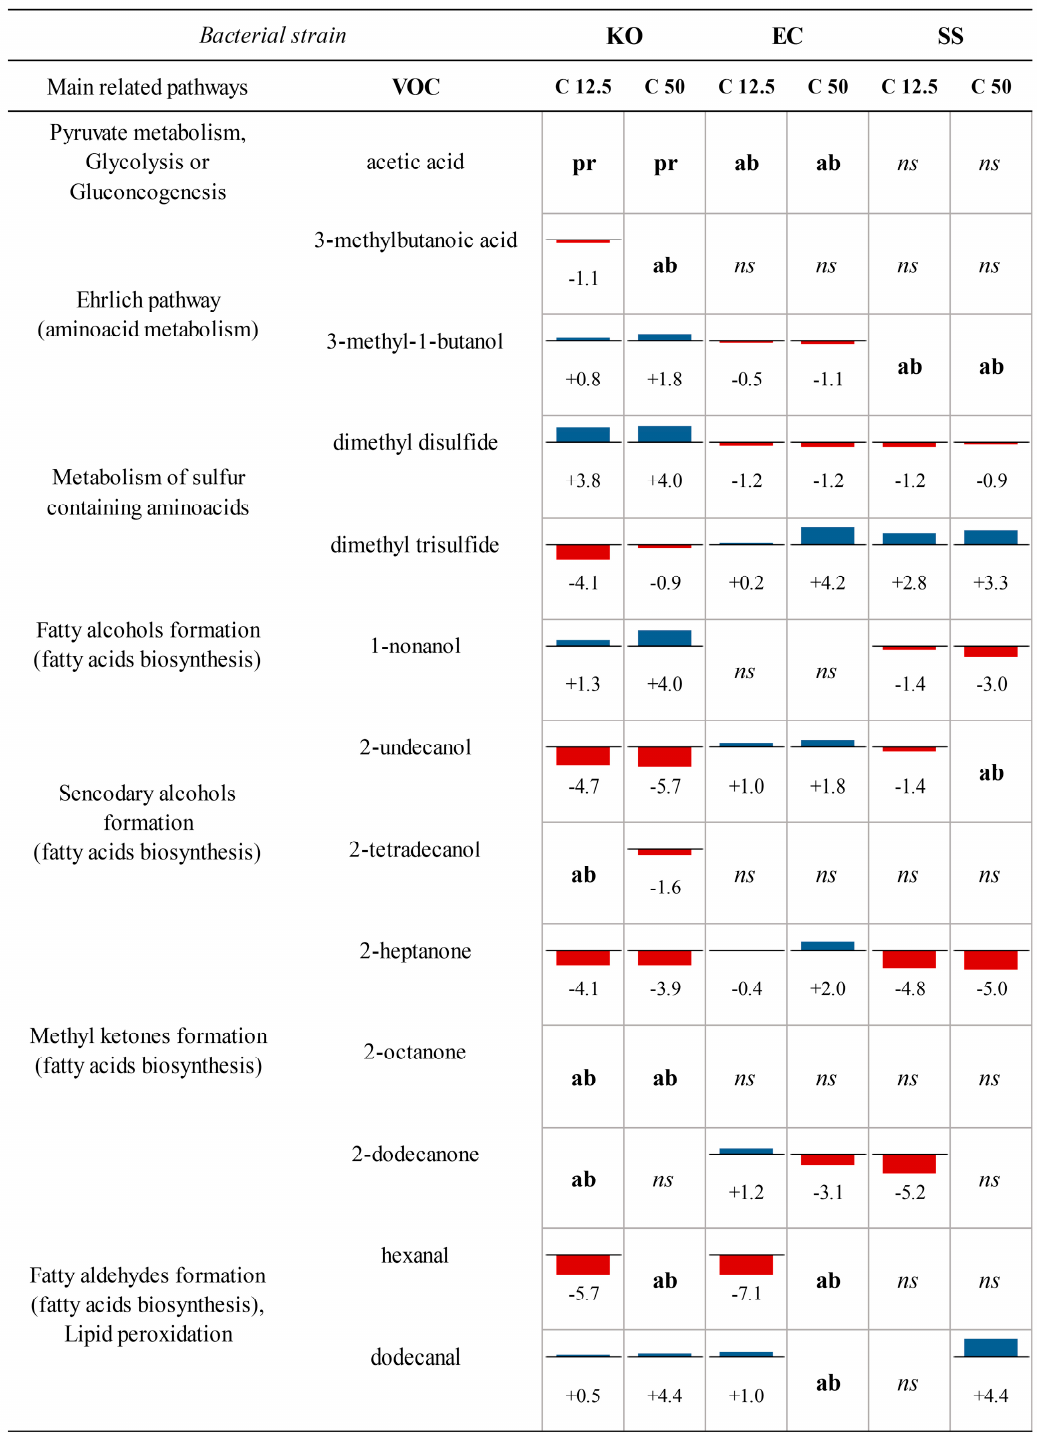
Figure 7. Combination of charts showing altered VOCs and addressed bacterial metabolic pathways, where numbers inside boxes display the base 2 logarithm of fold-change calculated with respect to the response in untreated strain; pr = produced only after AgNPs addition, ab = absent after AgNPs addition, ns = not significant alteration ( p > 0.05), KO— K. oxytoca , EC— E. coli , SS— S. saccharolyticus , C—concentration (µg mL − 1 ), VOC—volatile organic compound [61].